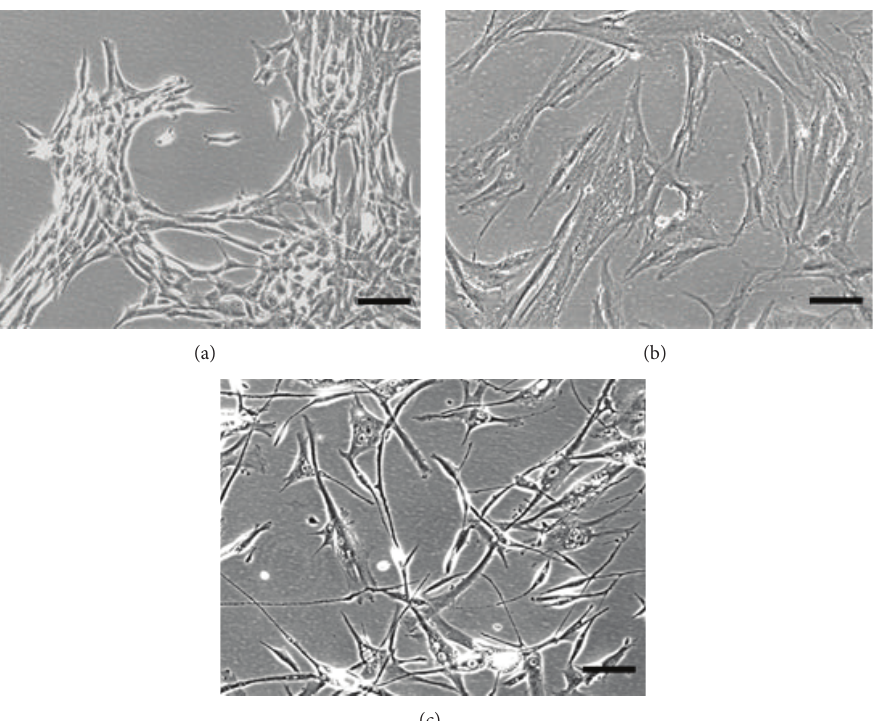
Figure 1: Morphology of hMSC colonies . Morphology of subconfluent hMSC colonies at day 8 cultivated in either MSCGM-CD (a), MSCGM (b), or PowerStem (c). 7mL of bone marrow per donor were seeded in respective media. Representative pictures have been taken at 100x magnification. Scale bar (black) length = 100 𝜇